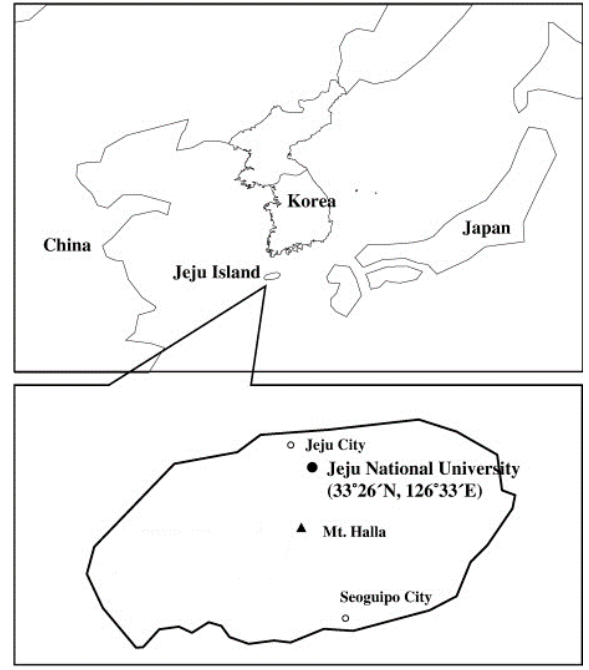
Figure 1. Map of Jeju Island showing the sampling site.